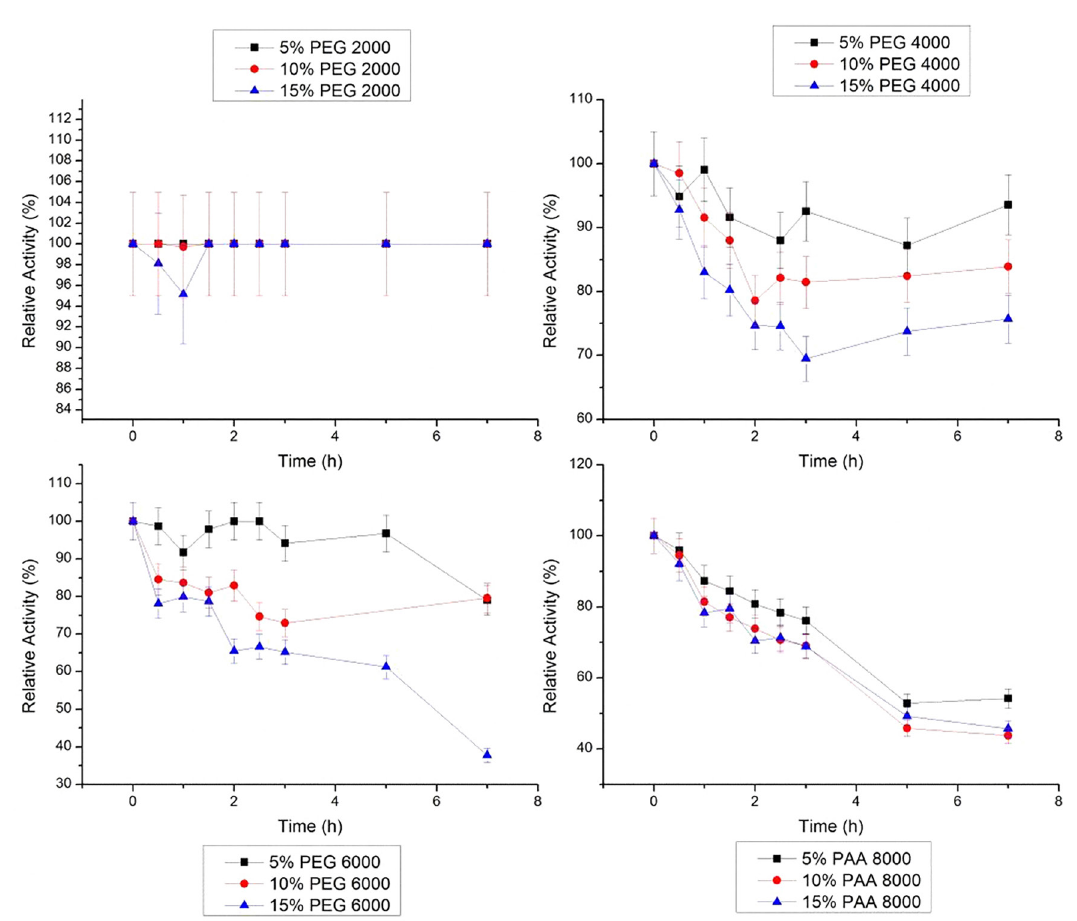
FIGURE 7 - Relative stability of bromelain at 40 ºC in PEG 2000, 4000, 6000 g/mol and PAA 8000 g/mol at three concentrations (5, 10 and 15% w/w). The error bars refer to standard